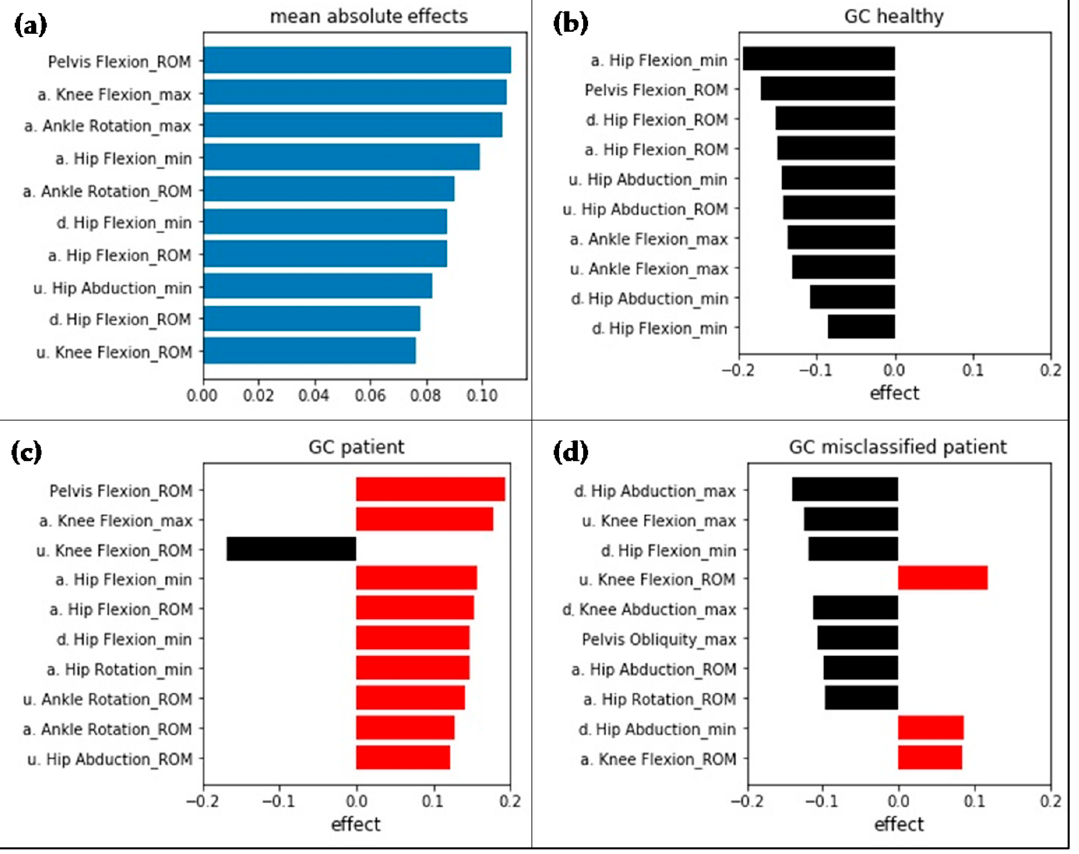
Figure 4. ( a ) Global LIME results as mean absolute effects. The analyzed instances ( b – d ) correspond to the instances displayed in Figure 3. Negative values indicate an effect towards the class of healthy subjects (black), positive effects towards the class of patients after THA (red). Feature abbreviations: a. = affected side; u. = unaffected side; d. = difference affected, unaffected side.